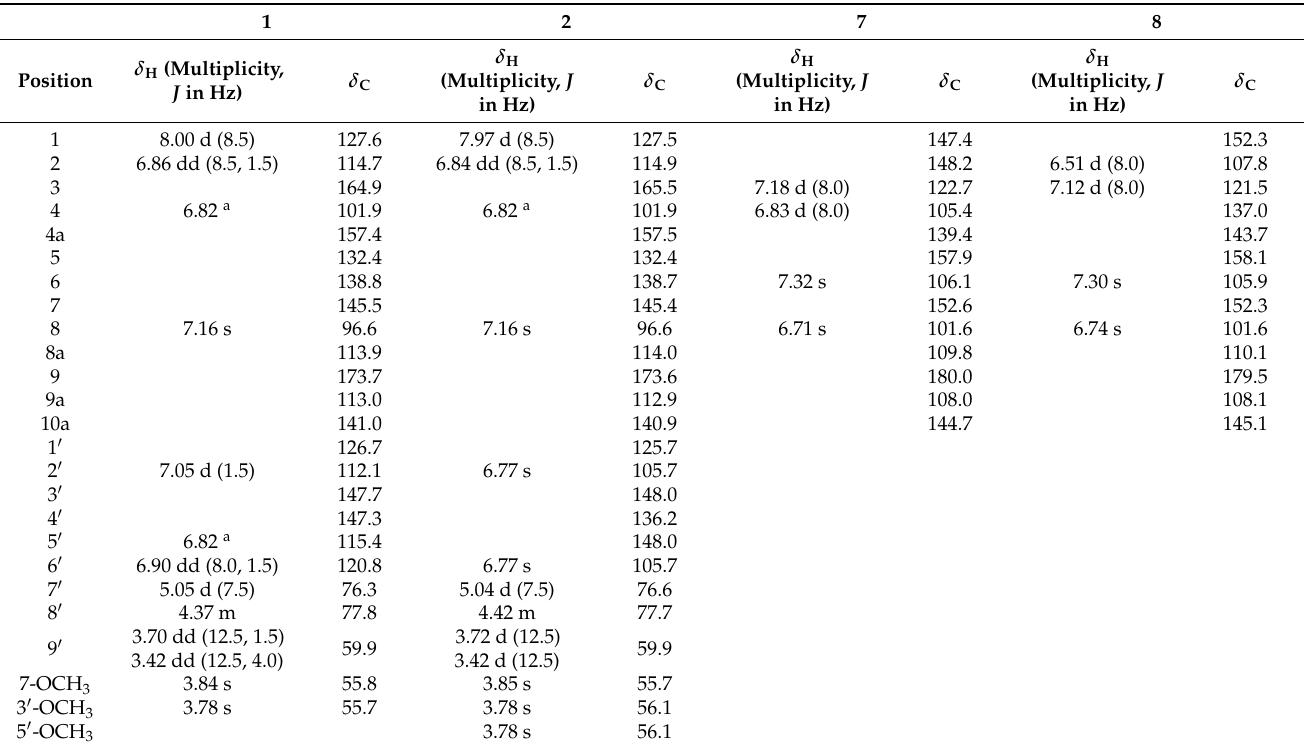
Table 1. 1 H (500 MHz) and 13 C NMR (125 MHz) data of compounds 1, 2, 7 and 8 (in DMSO- d 6